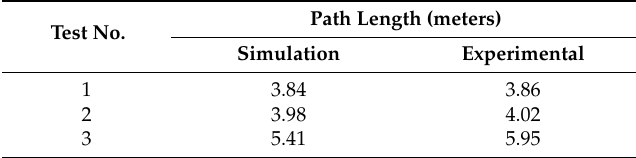
Table 3. Lengths of the paths during the experiments and the simulation. Test No.